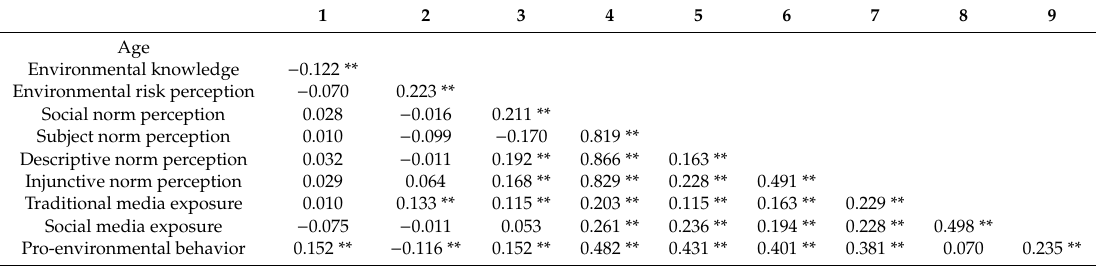
Table 2. Pearson intercorrelation of main variables (n =